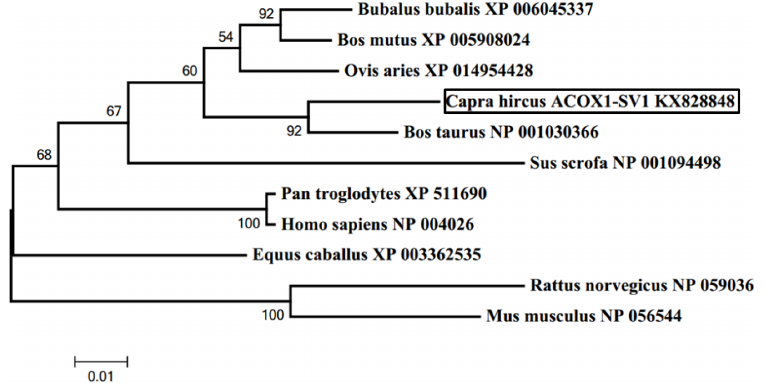
Figure 4. Phylogenetic tree of ACOX1-SV1 made by MEGA 5.1. Note: the tree was constructed based on amino acid similarities of the full mRNA sequences by MEGA 5.1. The accession numbers and description of the sequences used for the construction of the tree were shown in Table 2. The numbers on the joints were bootstrap test values, and the branch length represents the evolutionary time.